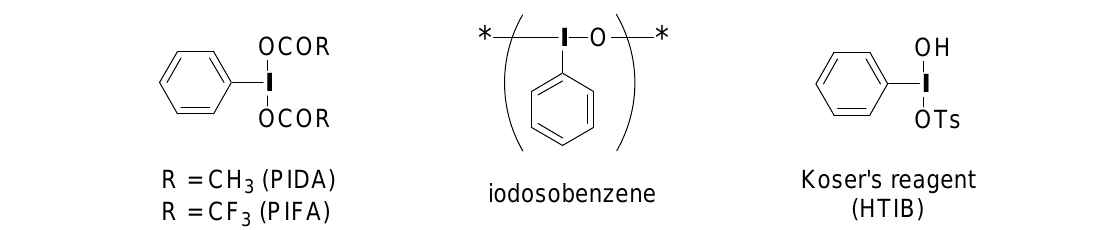
Figure 1. Representative hypervalent iodine(III)